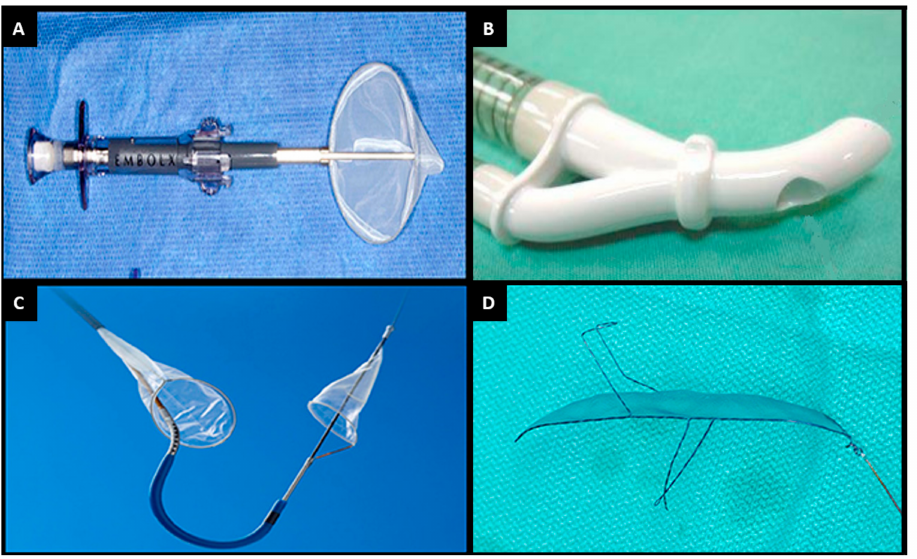
Figure 4. Currently available cerebral embolic protection devices. ( A ) Embol-X. ( B ) Cardio-Gard. ( C ) Sentinel. ( D ) TriGUARD. Adapted with permission from Armijo, G. et al.; Front. Cardiovasc. Med. ; 2018